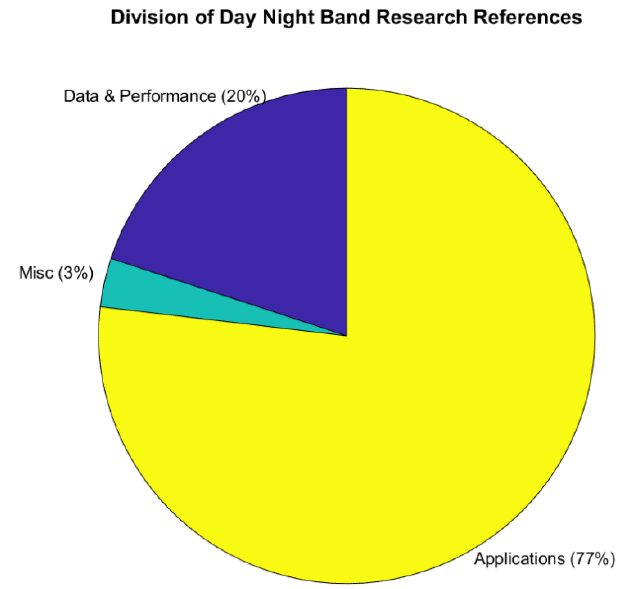
Figure 3. Percent of references between the top three categories in the database.